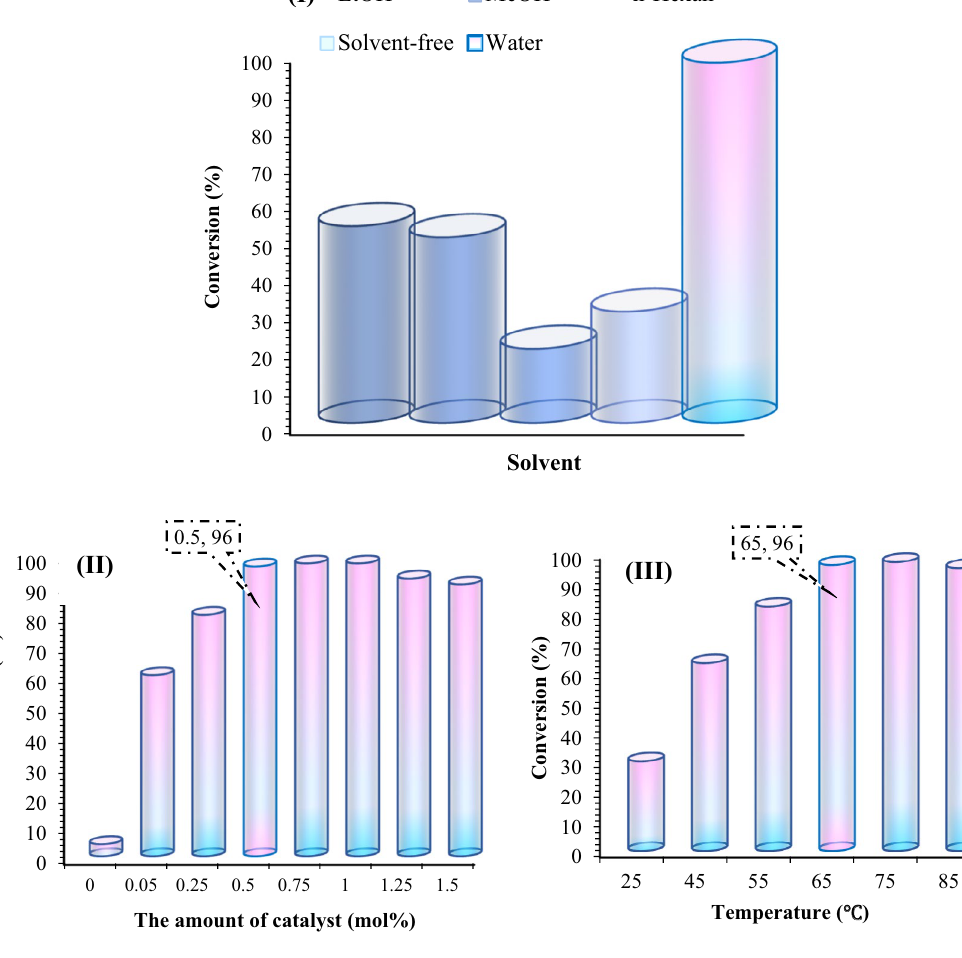
Figure 8. Screening of solvent, amount catalyst, and temperature for click reaction with a molar ratio of benzyl chloride, sodium azide, phenylacetylene and Fe 3 O 4 @Pectin@(CH 2 ) 3 -Acetamide-Cu(II) as